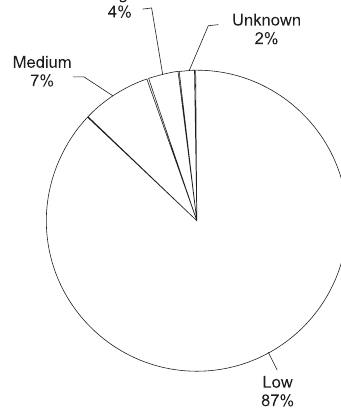
Fig. 4: Families of alien plant species in NKP. Fig. 5: Impact of alien plant species in